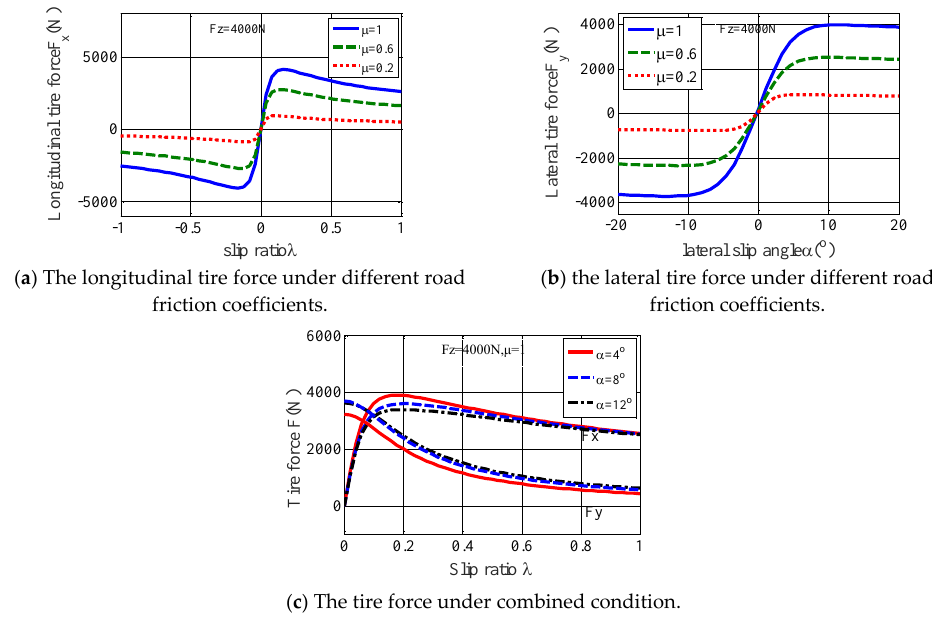
Figure 2. The tire force under different conditions.